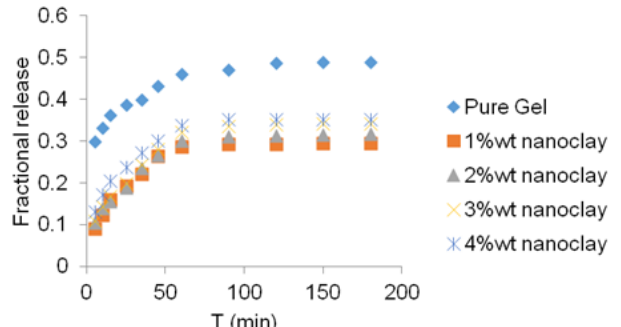
Fig. 11. Fractional release of hydrogels vs